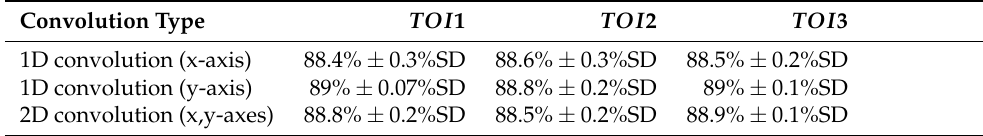
Table 1. The classification accuracy depending on the convolution type and the EEG segment. Convolution Type